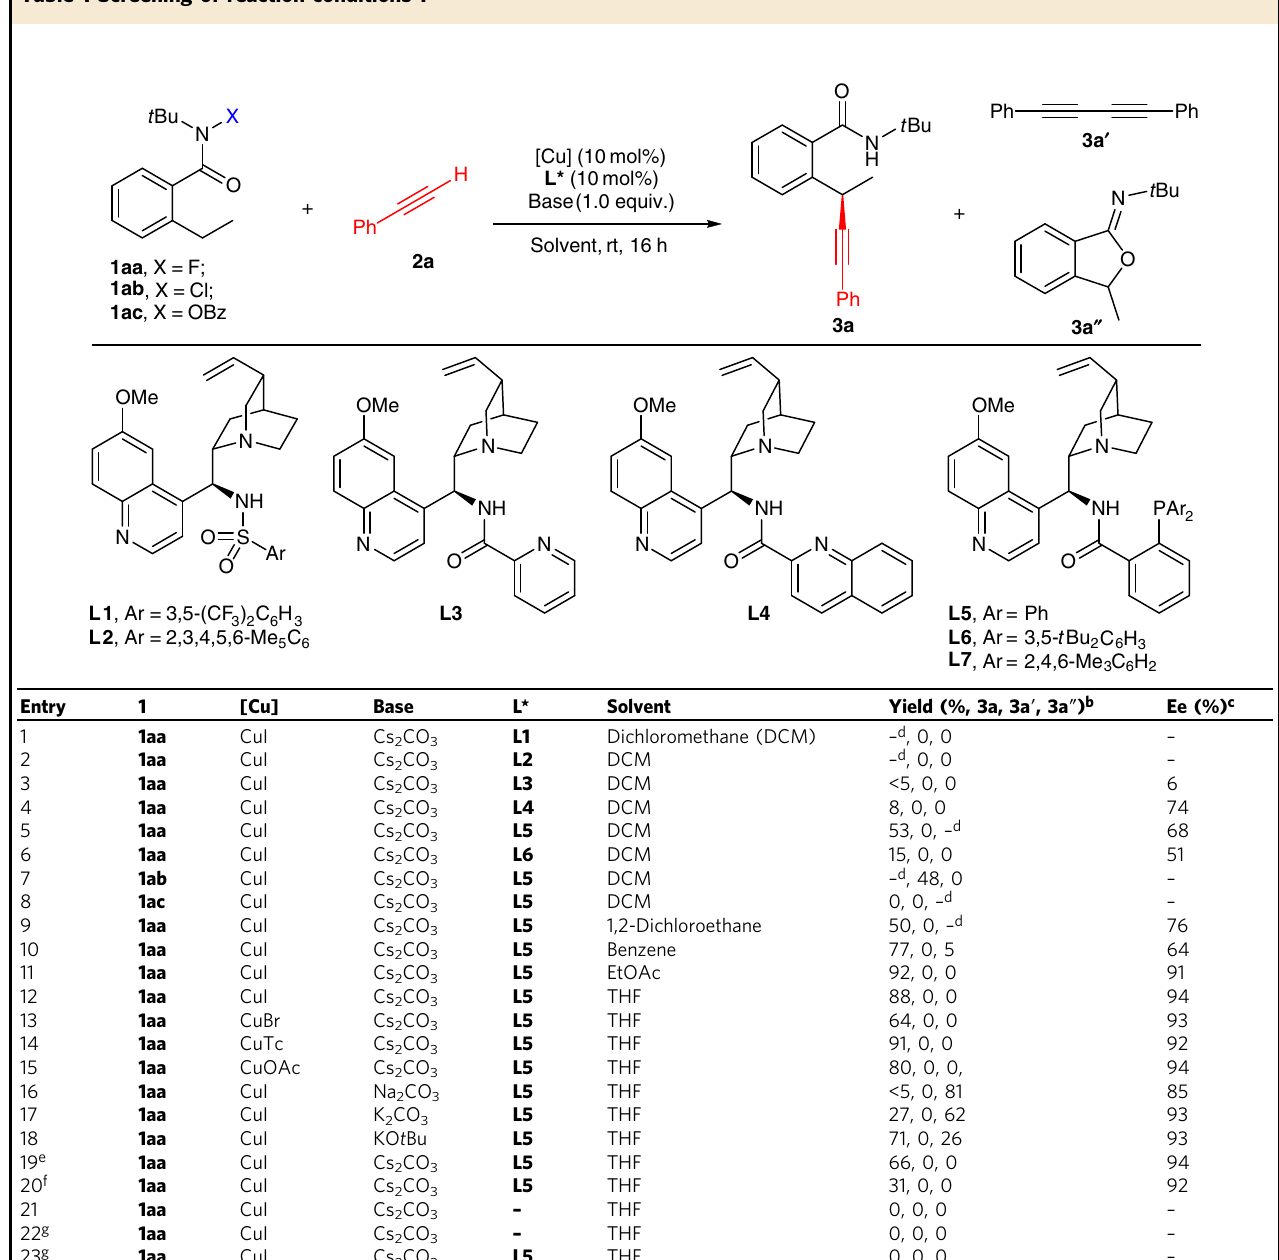
Table 1 Screening of reaction conditions a